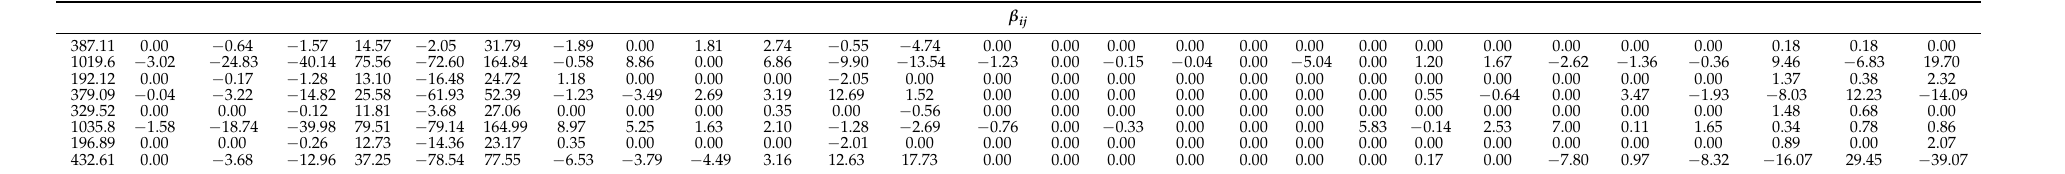
Table A3. Sensitivity of the thermal analysis parameters in Table 3.